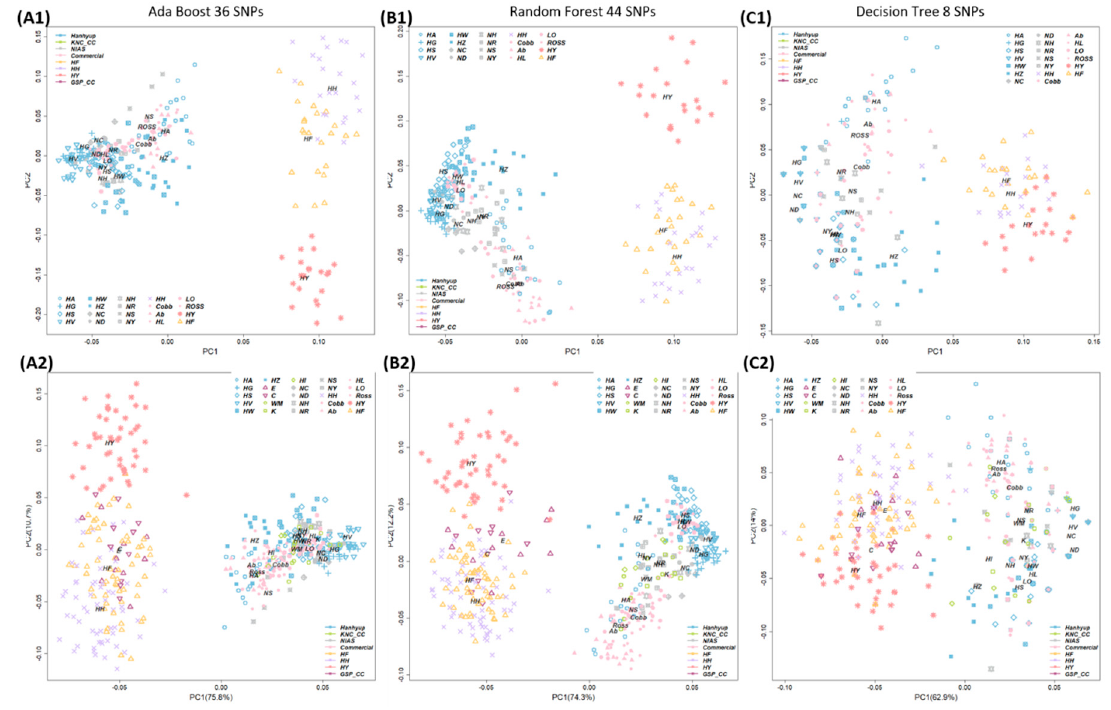
Figure 7. Classification results using marker combinations with the minimum number of SNPs (36, 44, and 8, respectively) selected by the feature-selection function of AdaBoost, Random Forest, and Decision Tree machine learning algorithms. ( A1 , B1 , C1 ) Classification results using Sample Set 1 (selected markers). ( A2 , B2 , C2 ) Classification results using Sample Set 2 (validation samples) after Sample Set 1 was used as training data. In the verification stage, the best-fitting models were the AdaBoost and Random Forest models. The minimum number of markers was set as 36 in the AdaBoost model. NC, Rhode Island Red C; ND, Rhode Island Red D; NH, Cornish H; NS, Cornish S; NR, Red Korean native chicken; NY, Yellow Korean native chicken; HH, Hanhyup H; HF, Hanhyup F; HY, Hanhyup Y; HW, Hanhyup W; HS, Hanhyup S; HG, Hanhyup G; HV, Hanhyup V; HA, Hanhyup A; HZ, Hanhyup Z; Ab, Arbor Acre; Cobb, Cobb broiler; Ross, Ross broiler; LO, Lohmann brown; HL, Hyline brown.